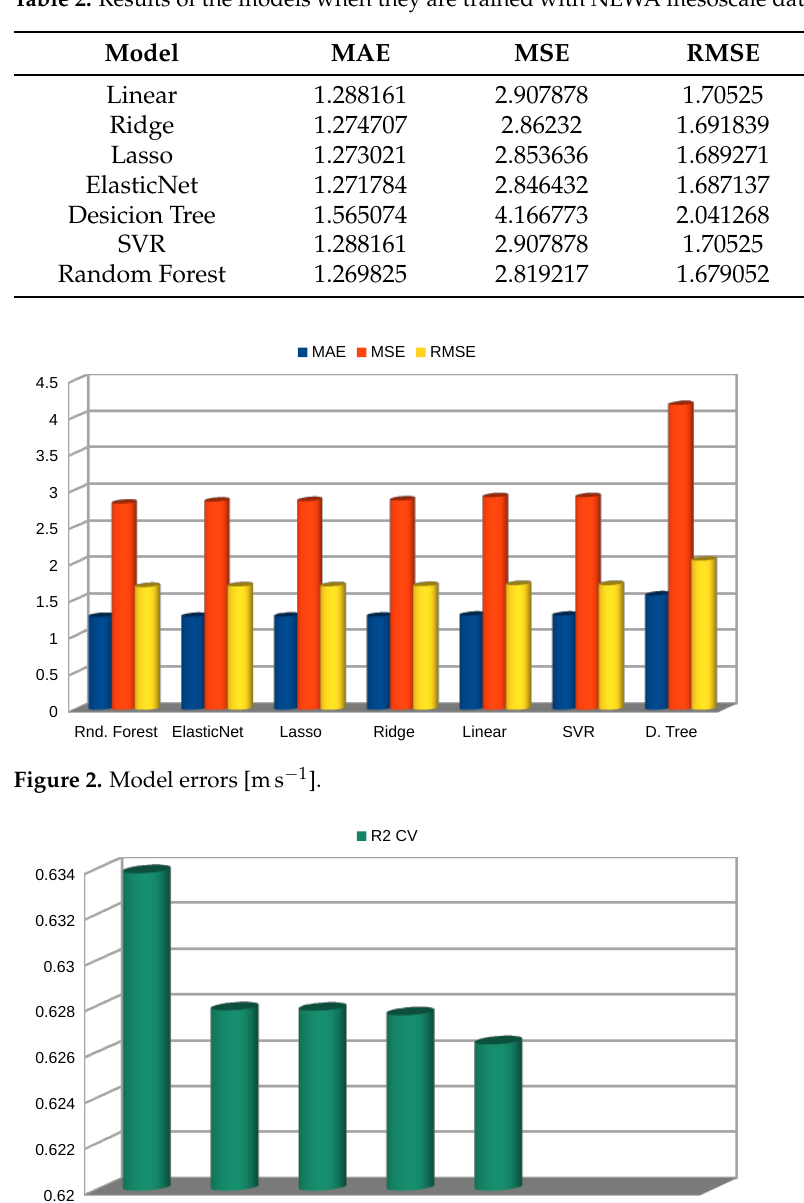
Table 2. Results of the models when they are trained with NEWA mesoscale data.